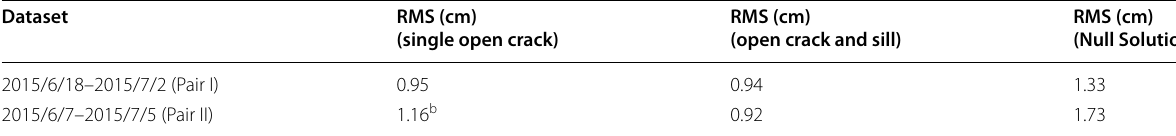
a The RMS of the null solution corresponds to the RMS of the data themselves b The dataset was not used for the model inversion